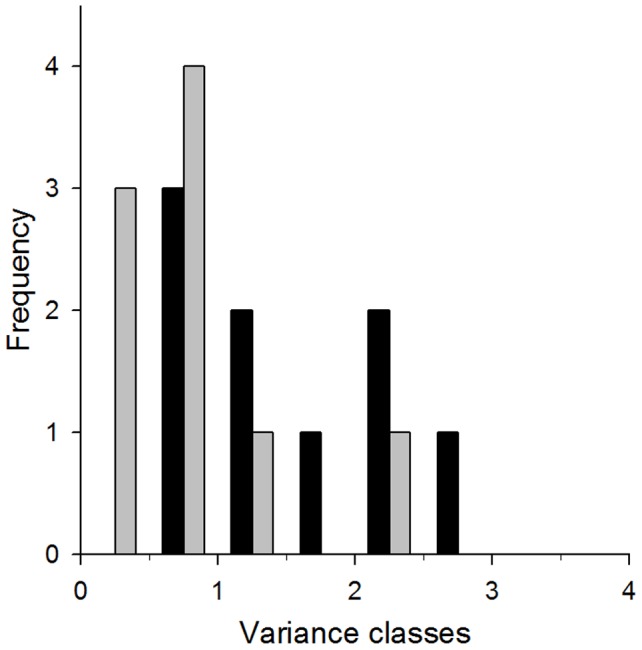
Frequency distribution of within-individual variances for stable carbon isotope ratios (δ13C; black bars) and nitrogen isotope ratios (δ15N; grey bars).